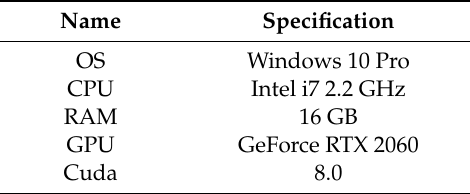
Table 2. Experimental Environment.